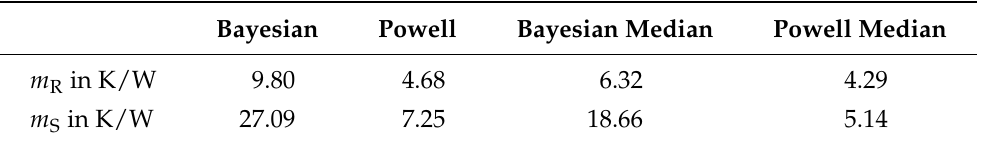
Figure 5. Example solution for network identification using Bayesian deconvolution and Powell optimization on the basis of six sections for a single realization of sparse noisy data with R SN = 50. The Bayesian solution is used to generate initial values for the optimization. In Table 4 the corresponding accuracy values are summarized. Table 4. Accuracy values for the solutions in Figure 5 and comparisons to the respective median values from Figure